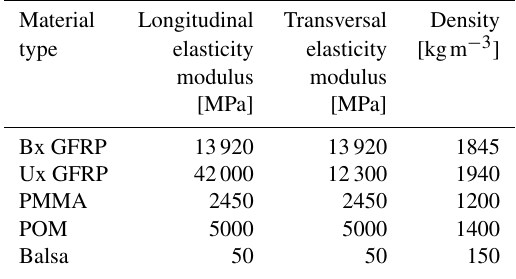
Table 8. Mechanical properties of the materials used for the W- and S-model